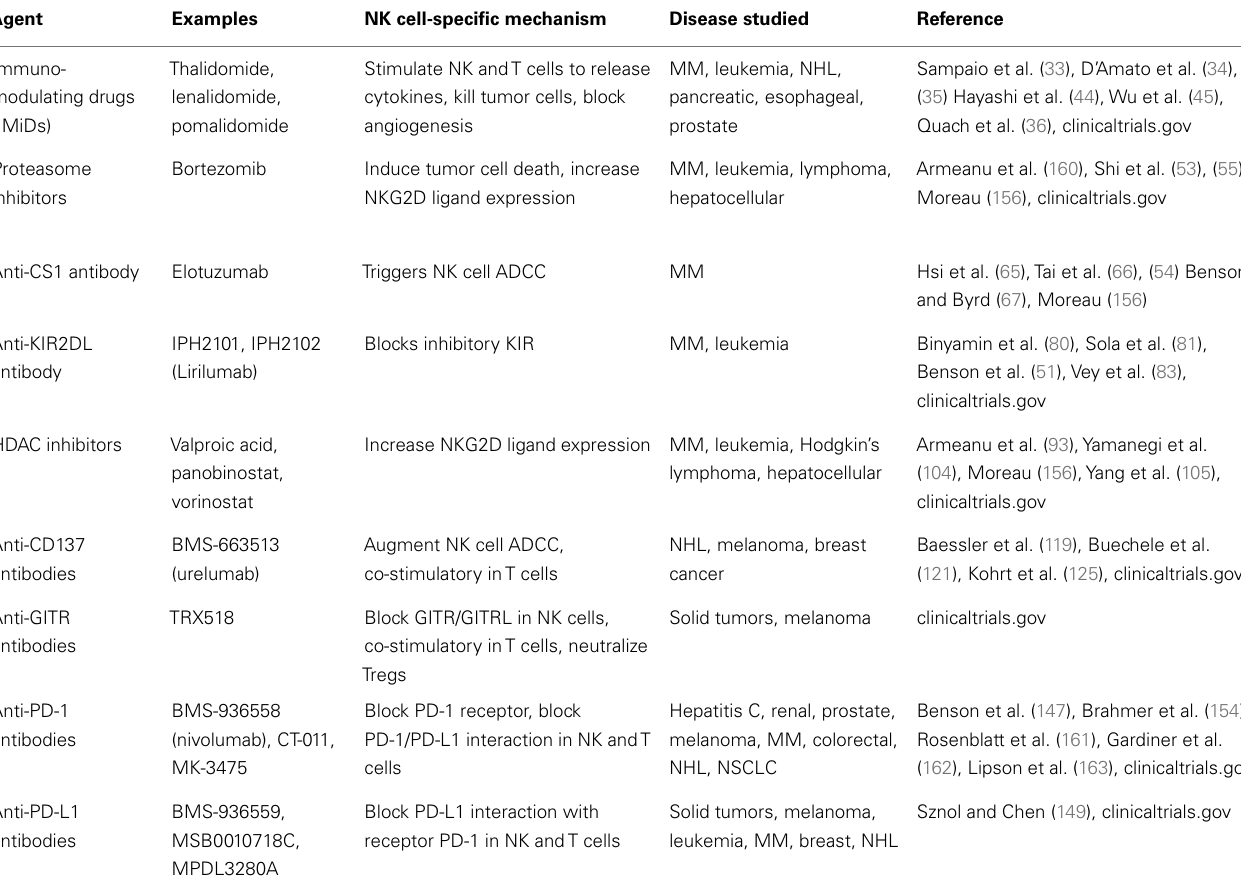
Table 1 | Summary of some major therapeutic agents discussed in the